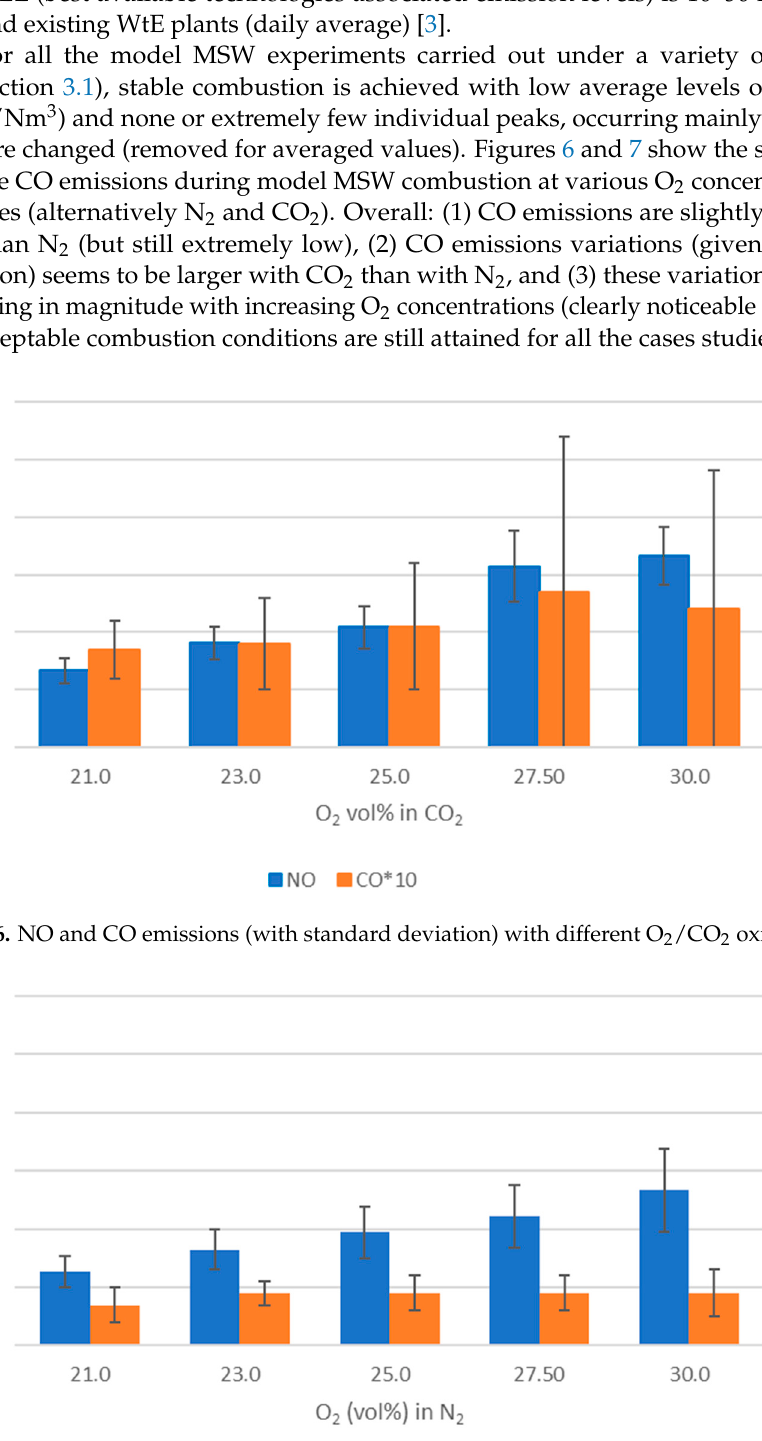
Figure 7. NO and CO emissions (with standard deviation) with different O 2 /N 2 oxidizer